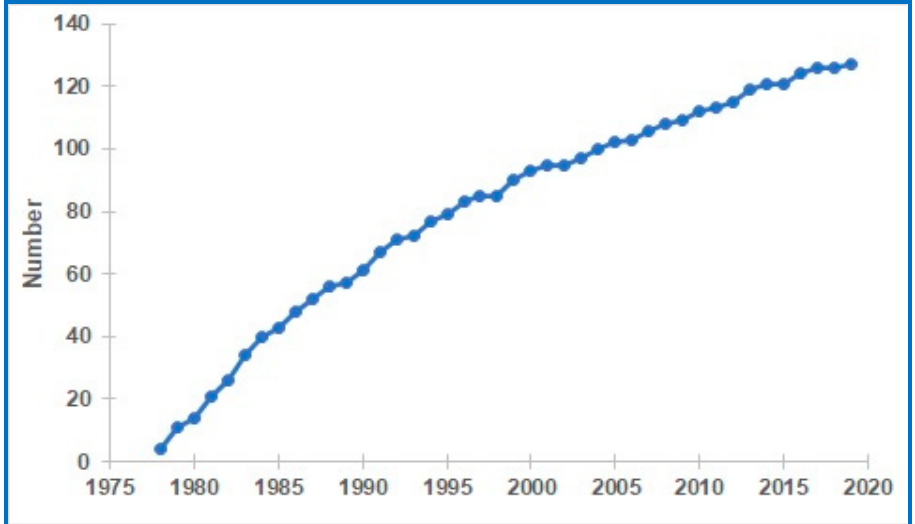
Figure 10. Cumulative listings of Criterion 7 sites ( http://whc.unesco.org/en/list ) (accessed on 19 January 2022).